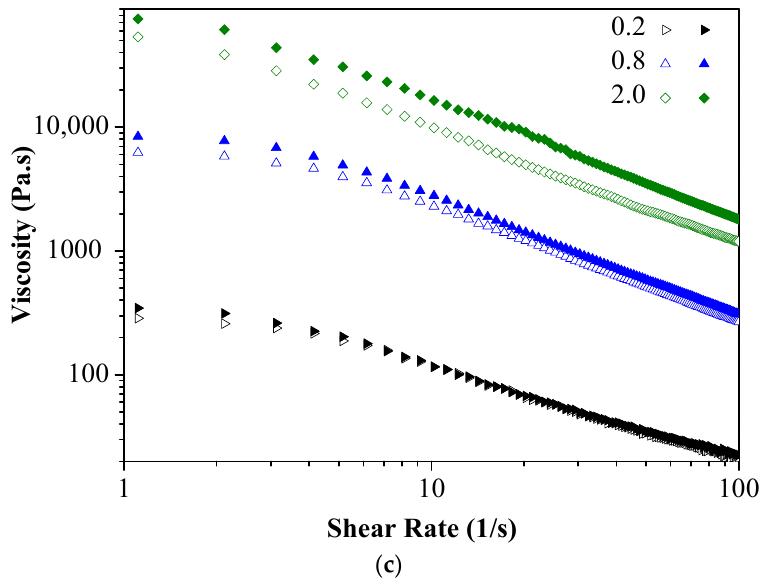
Figure 6. Effect of FG concentration (0.2/0.8/2.0%) on frequency sweep curves of the RBOB-FG emulsion-filled gel (solid markers), FG hydrogels (open markers) ( a ), G” / G ′ values ( b ), and shear viscosity curves ( c ). Table 1. Rheological parameters of the Herschel–Bulkley model for RBOB-FG emulsion-filled gels and FG hydrogel.